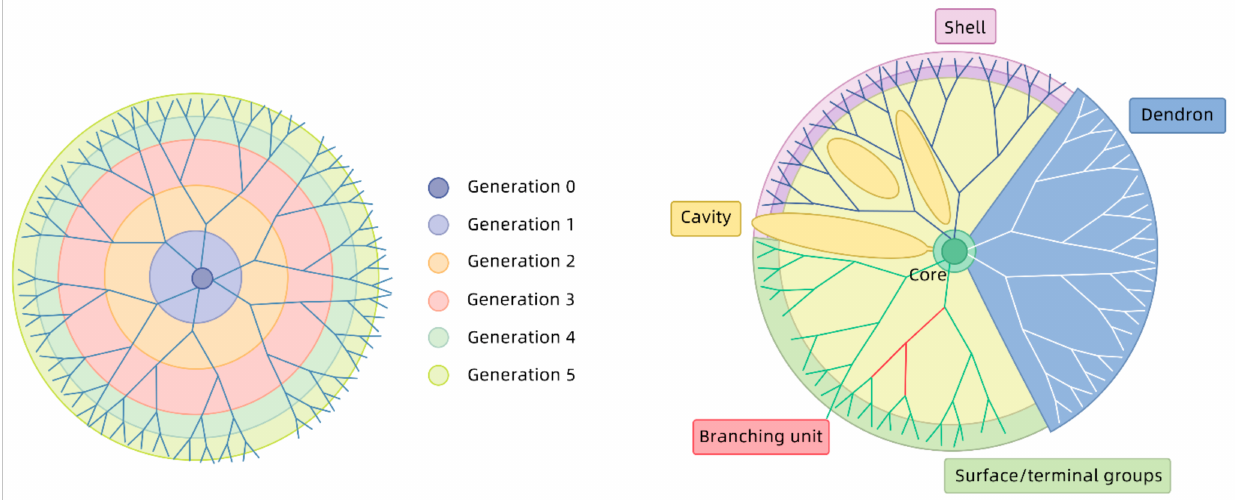
Figure 2. The typical structure of PAMAM dendrimers.